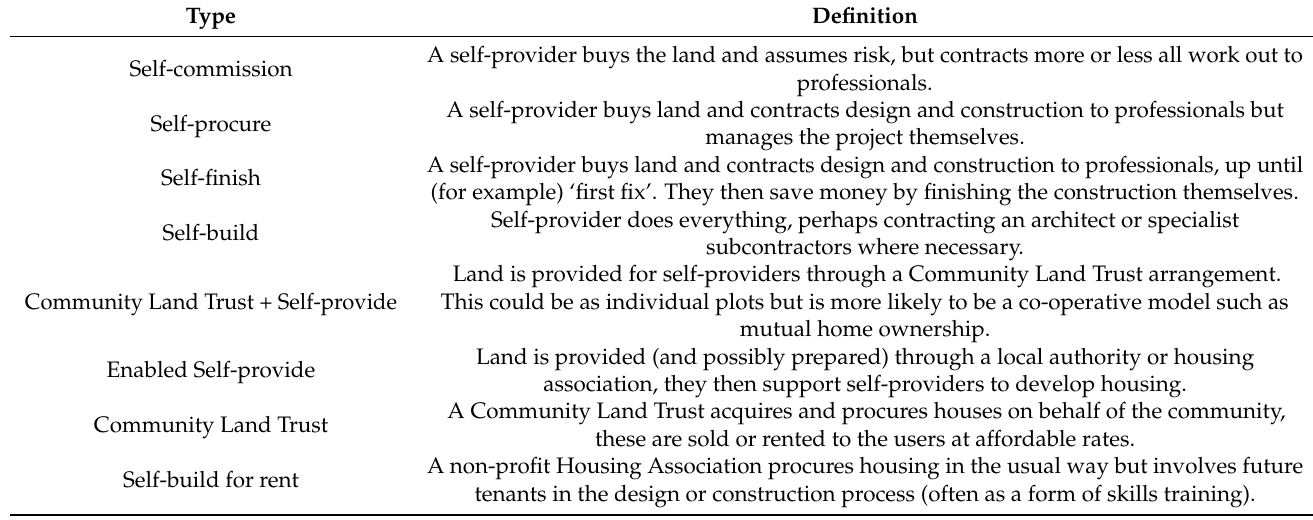
Table 1. Types of Self-provided